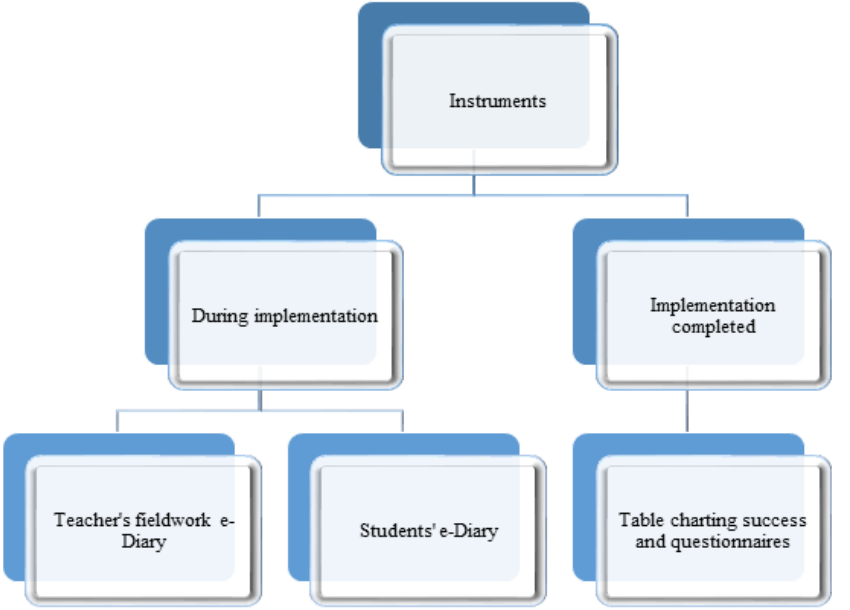
Figure 1. Data-gathering